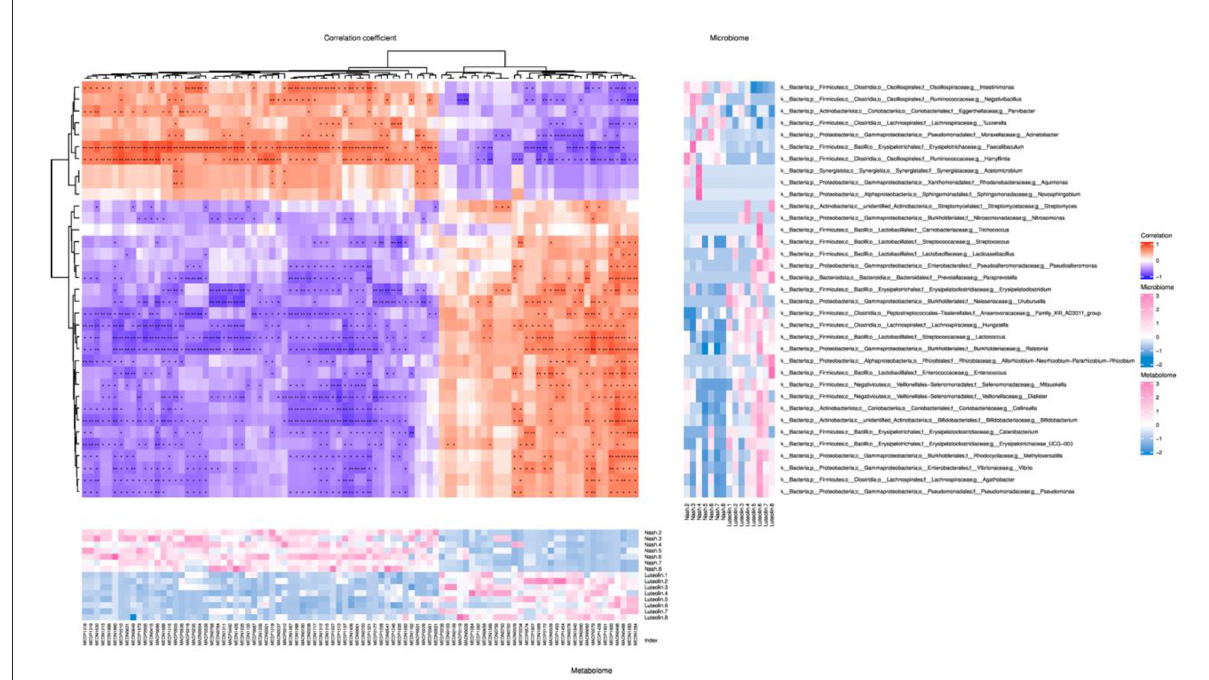
FIGURE7 Spearman’s correlation cluster heatmap of differential gut microbiome and differential metabolites at genus level (The central heatmap showed the magnitude of the Spearman’s correlation between differential microbes and differential metabolites. * p < 0.05, ** p < 0.01, n = 6–8 per groups. The abscissa represented metabolites, and the ordinate represented microbes. The heatmap on the right showed the abundance of microbes at genus levels, and the heatmap on the bottom showed the abundance of metabolites.).